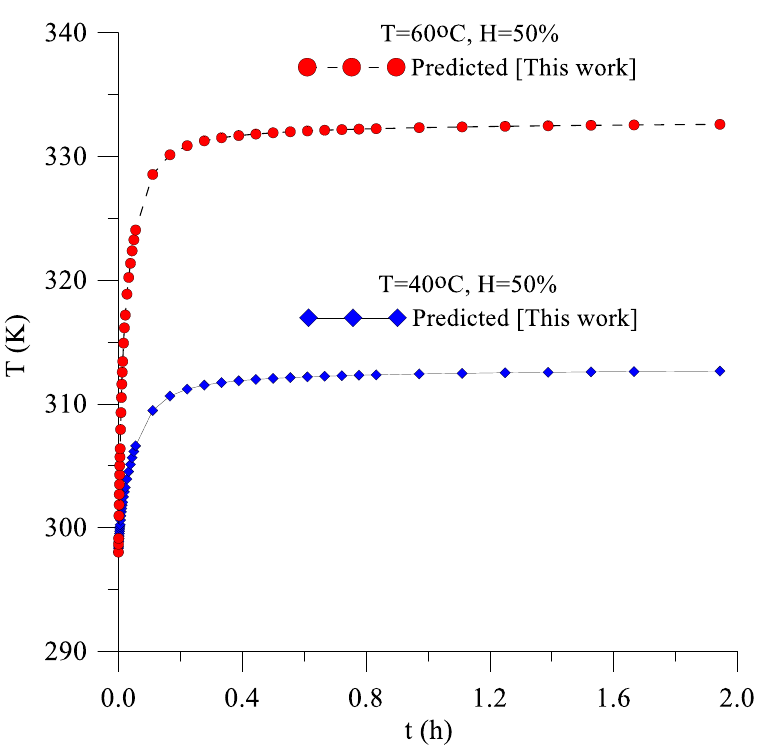
Figure 5. Average temperature of lentil grain over time during drying at 40 °C and 60 °C and a relative humidity of 50%.